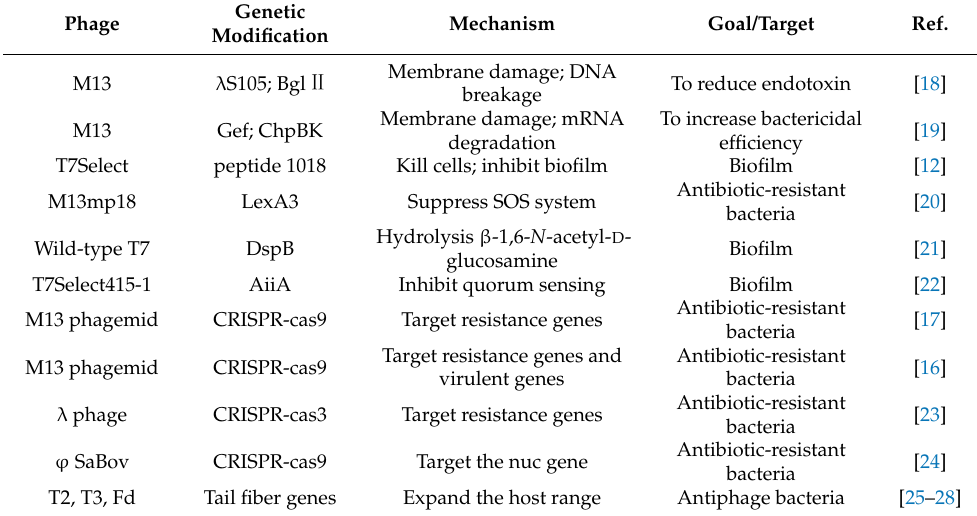
Table 1. Genetic engineering methods applied in phage modification.